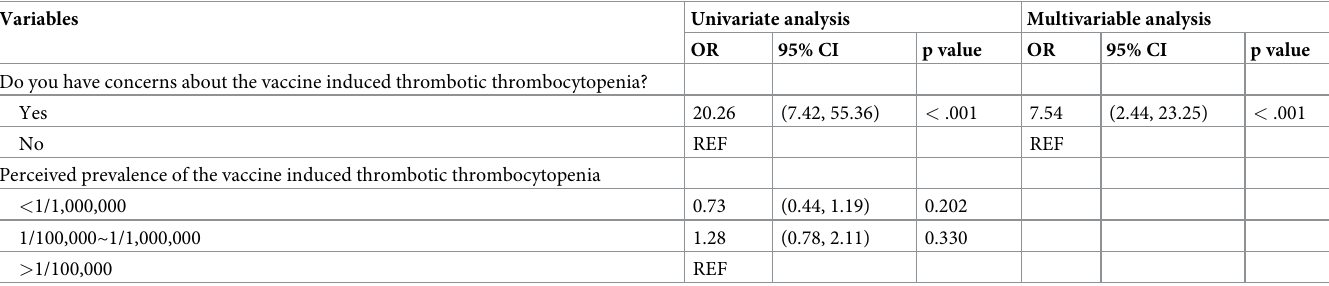
second dose of the vaccine (Fig 2). Overall, 220 respondents (23.3%) reported that they had decided to receive the second dose after the hospital-wide campaign. Among them, 125 (56.8%) selected ‘hospital-wide campaign’ as the motive for their decision. The second most common reason was ‘national policy’ ( N = 46, 20.9%), followed by ‘recommendation by others’ ( N = 31, 14.1%) and ‘positive information obtained from media’ ( N = 17,